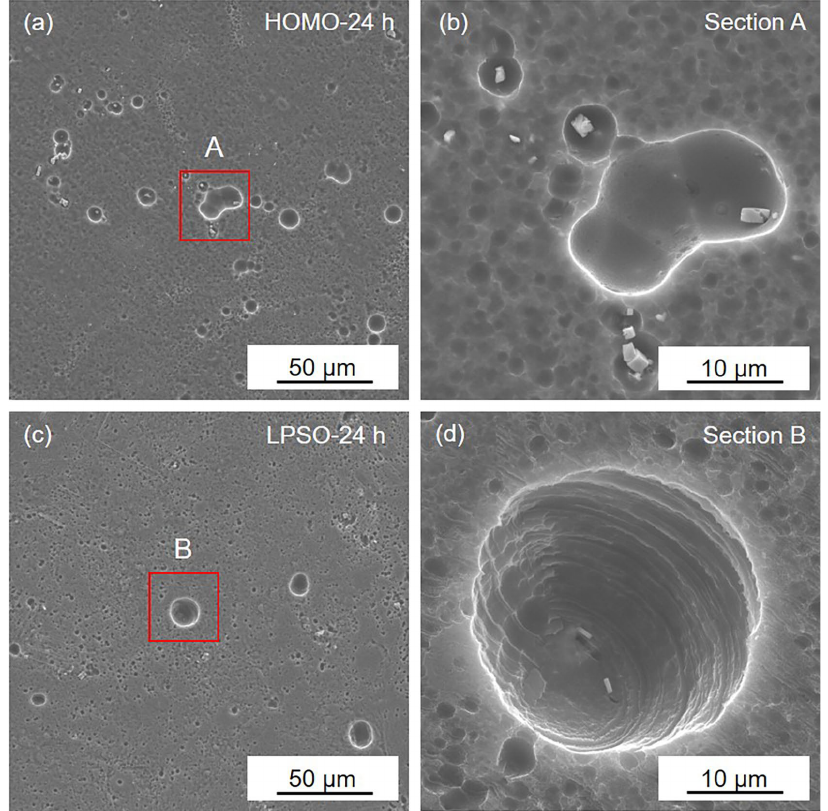
Figure 4. SEM images of ( a , b ) the HOMO and ( c , d ) LPSO samples after 1 h immersion.